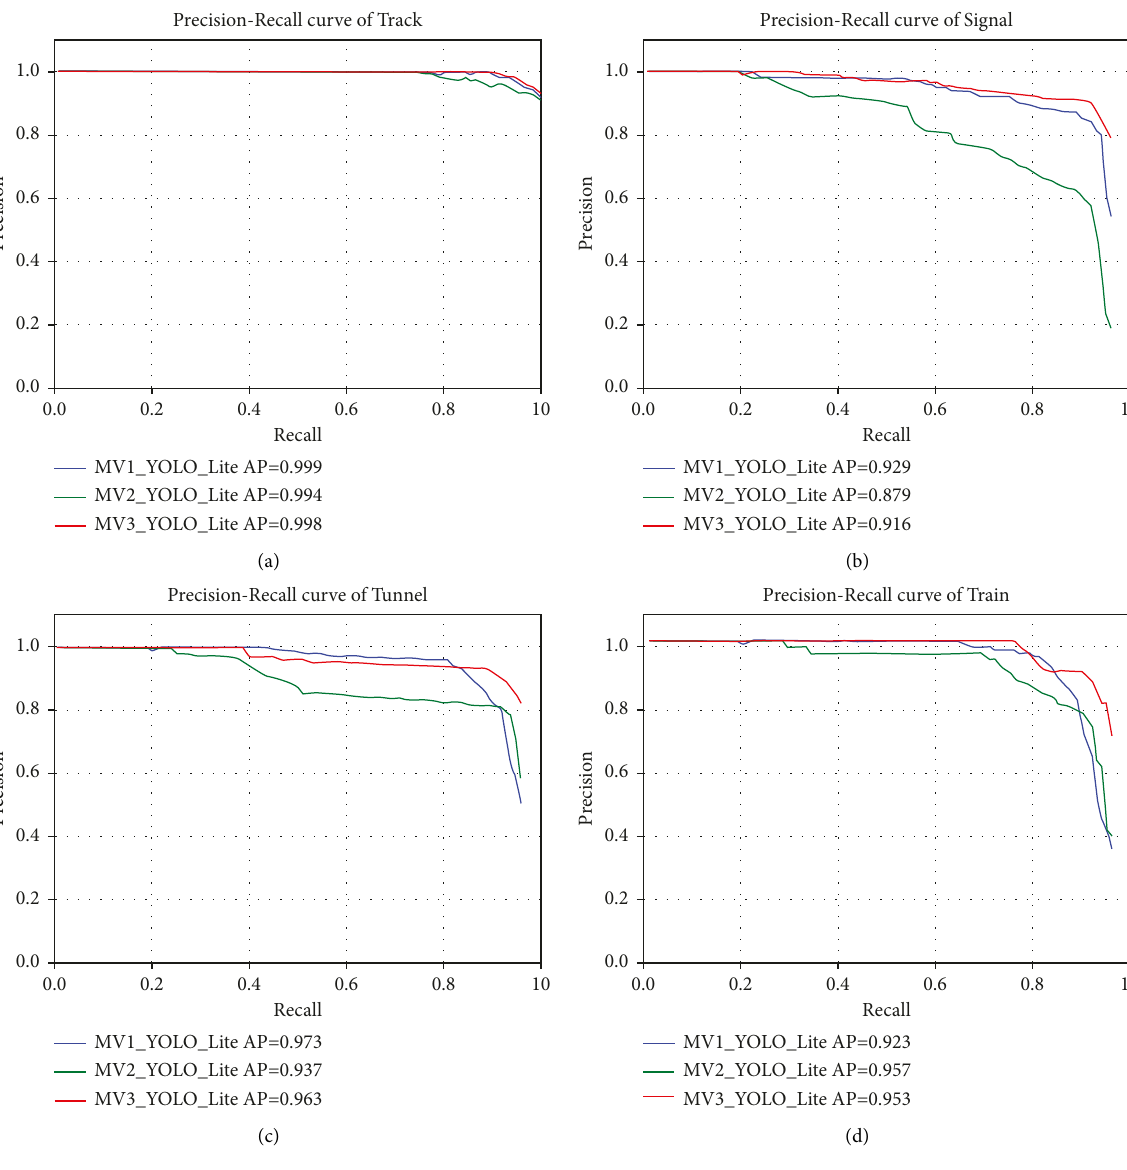
Figure 10: P-R curve of four types of targets. (a) P-R curve of track. (b) P-R curve of signal. (c) P-R curve of tunnel. (d) P-R curve of